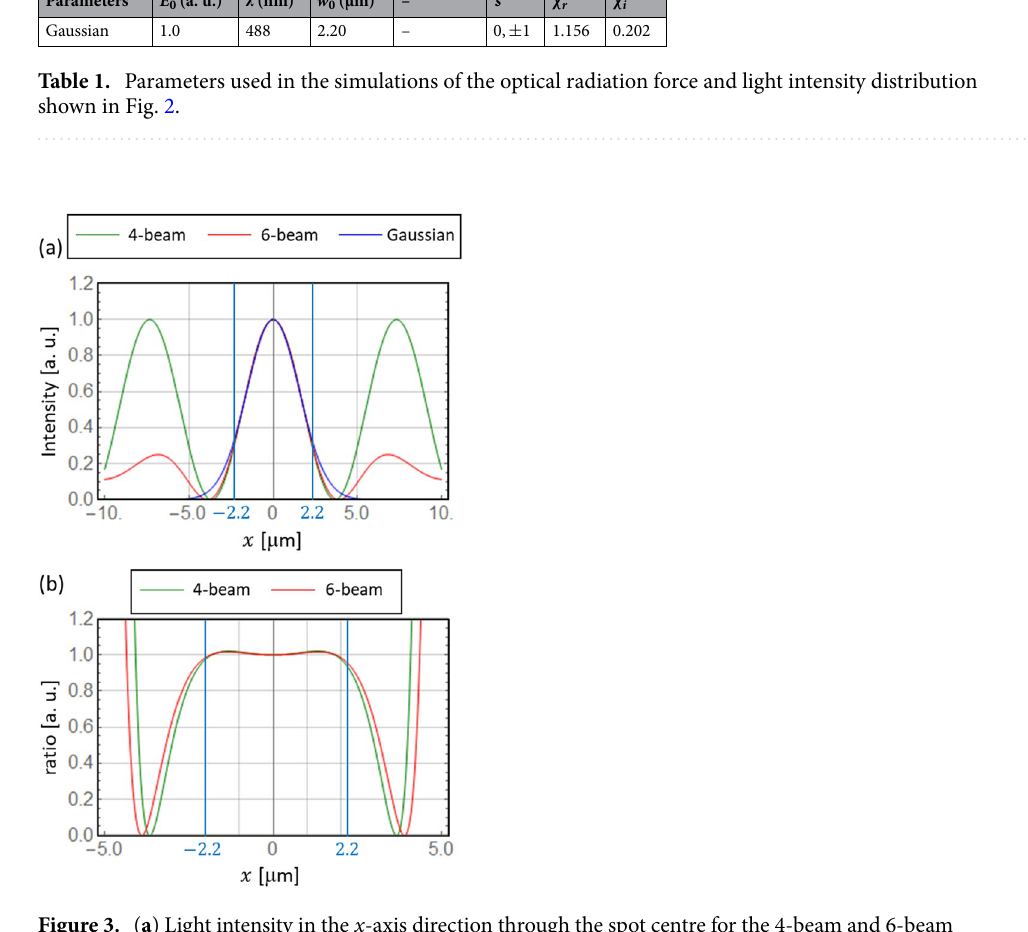
Figure 3. ( a ) Light intensity in the x -axis direction through the spot centre for the 4-beam and 6-beam interference patterns and the Gaussian beam. ( b ) Intensity ratio of the interference patterns to the Gaussian